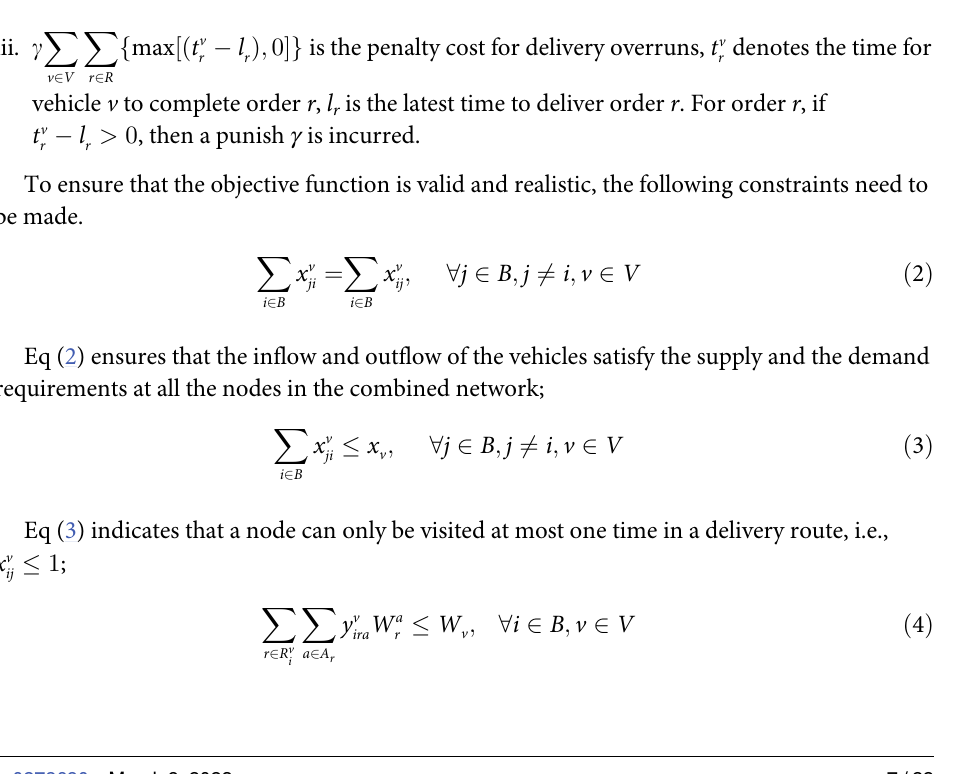
Fig 3. The final delivery plan of r 1 and r 2 . The illustration shows the order fulfillment model combining single store delivery and multi-store delivery.